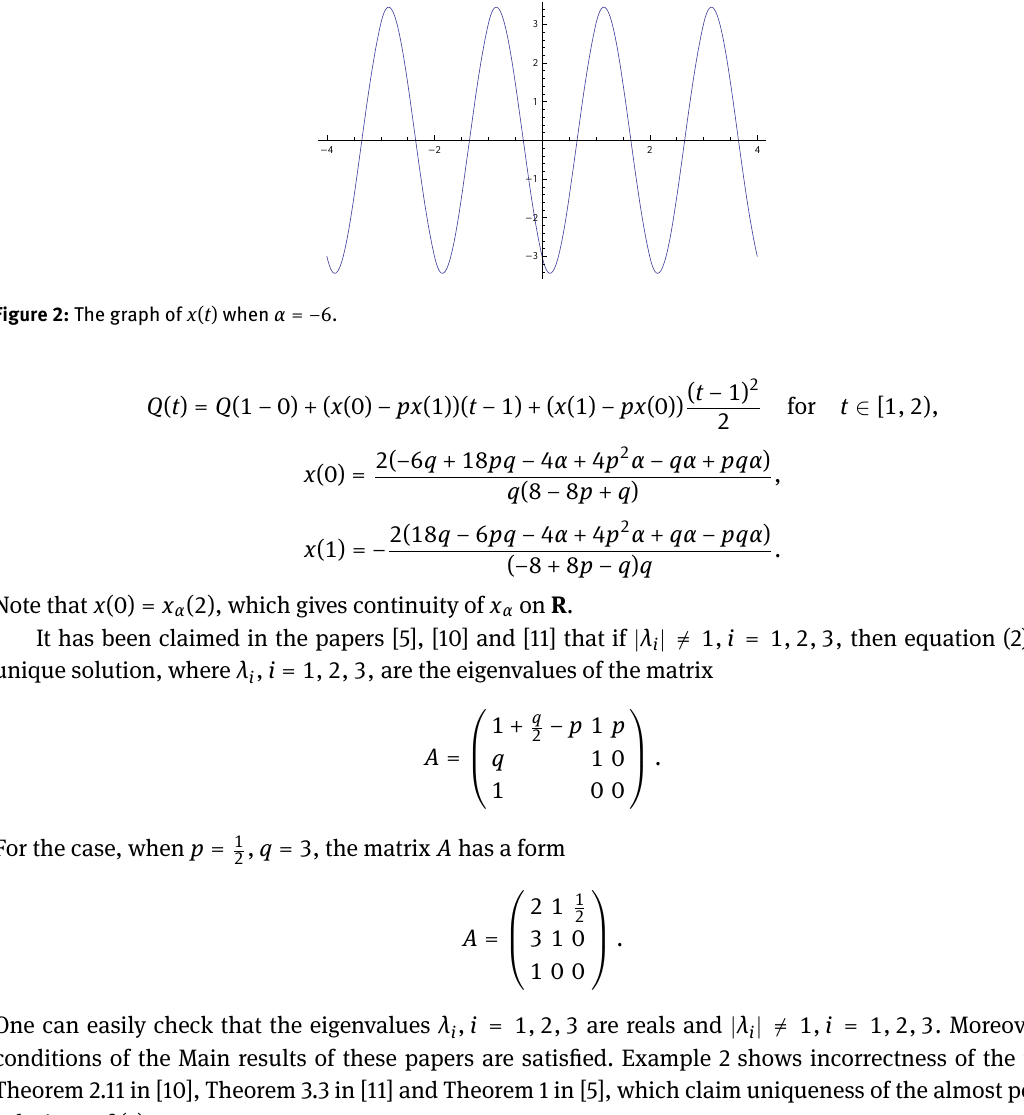
Figure 1: The graph of x ( t ) when α = −10 .